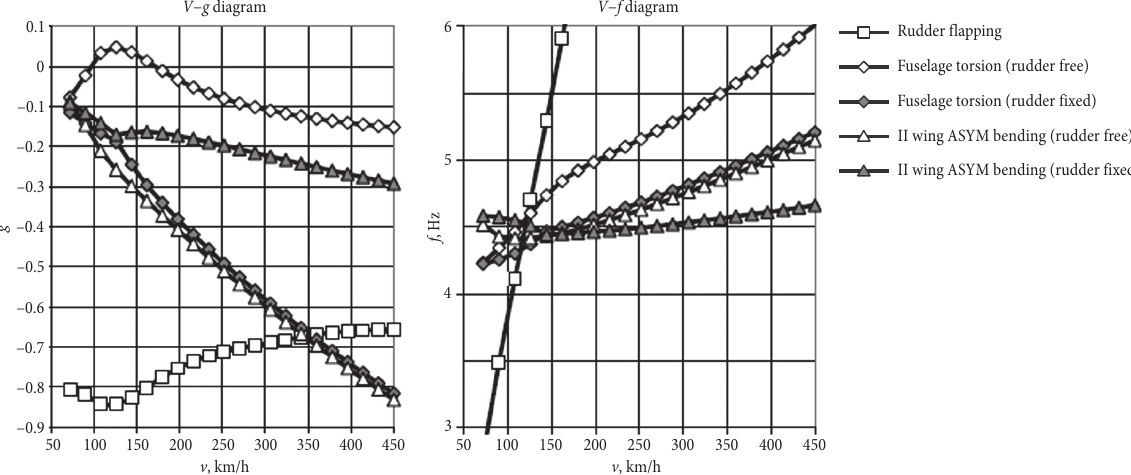
Fig. 8. V – g and V – f diagrams of sailplane LAK-17B with 18 m wing